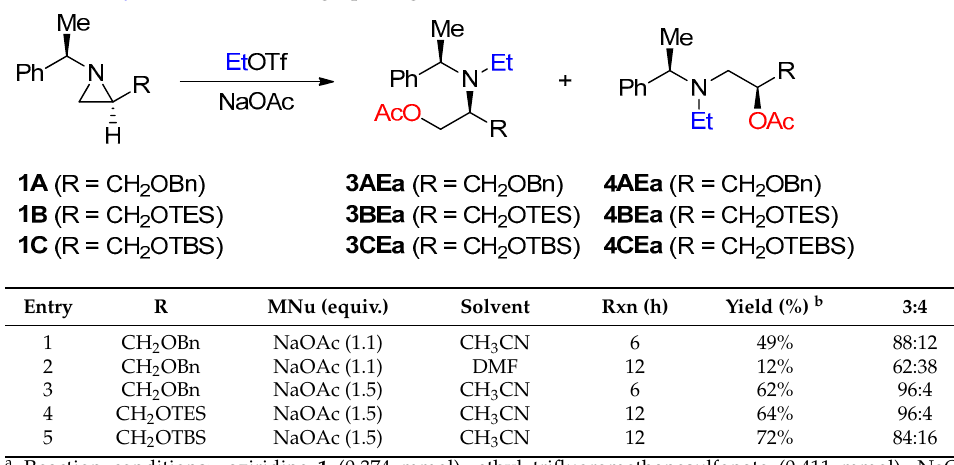
Table 1. Ethylative aziridine ring-opening reactions with EtOTf in CH 3 CN a .